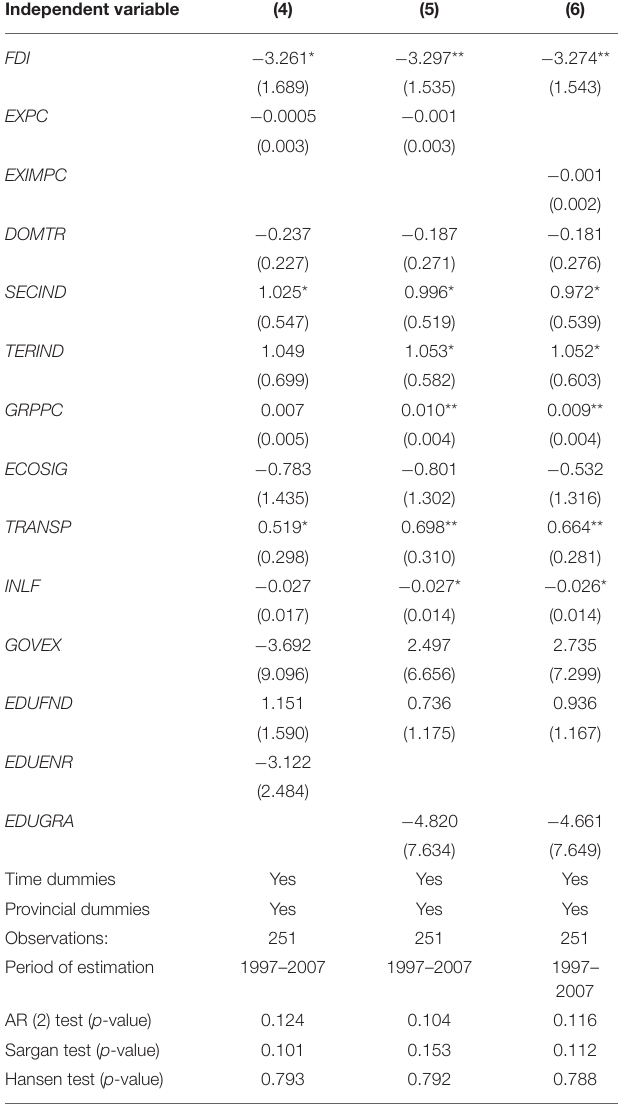
TABLE 4 | Robustness test (ii) for regional inequality and globalization. Independent